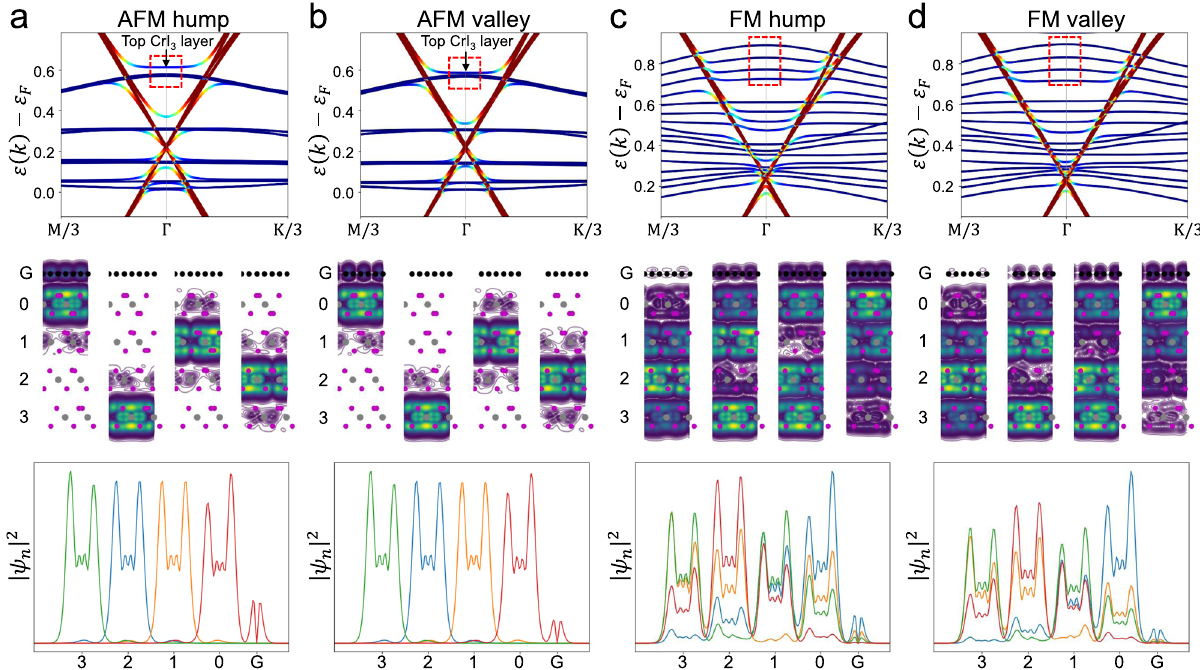
Fig. 5 The atomic registry-dependent band structure of G/four-layer CrI 3 under AFM and FM interlayer coupling. a – d The band structure and norm- squared wavefunctions of bands in G/four-layer CrI 3 with FM and AFM interlayer order in the hump and valley geometries. The top panel shows the band structure of G/four-layer CrI 3 . We indicate four states using red dashed lines shown in each of the four cases. The middle panel shows contour plots of the norm-squared wavefunctions of indicated states averaged over the y -direction of the heterostructure. The bottom panel shows the norm-squared wavefunctions of indicated states averaged over the entire